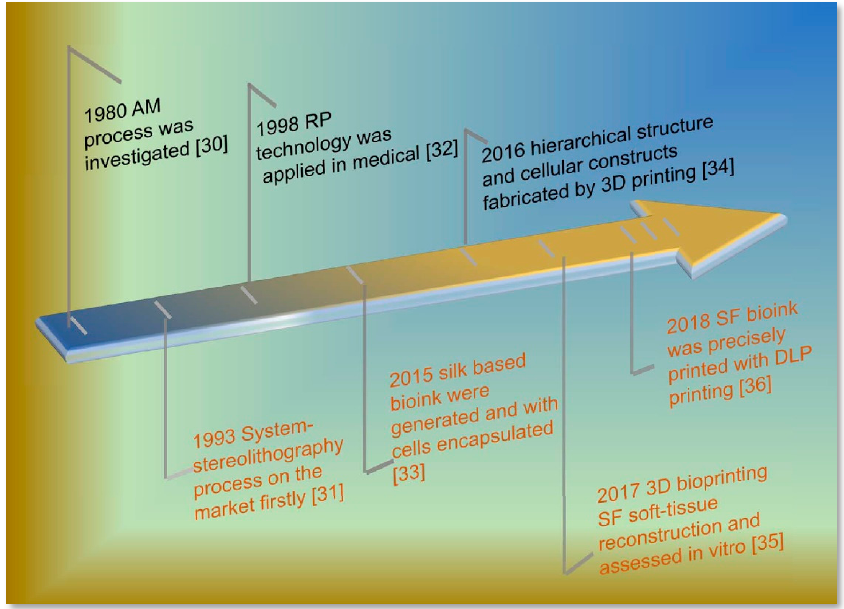
Figure 1. Timeline of the development of Silk fibroin (SF) based bioink in three-dimensional (3D) printing technology [30–36]. Additive manufacturing (AM); Rapid prototyping (RP); and, Digital light processing